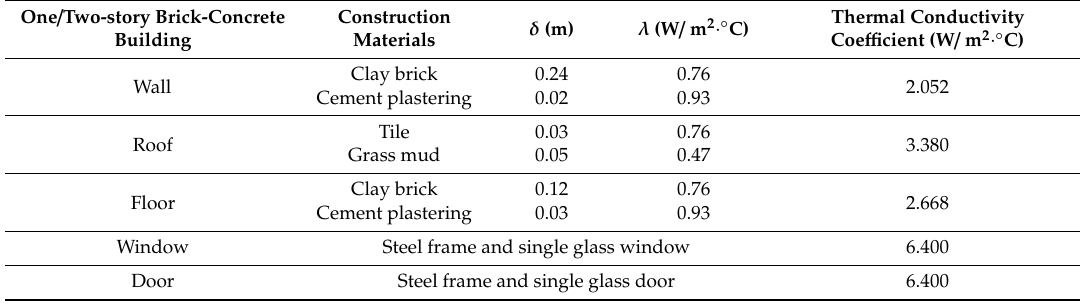
Table 12. Thermal conductivity coe ffi cient K i of one / two-story brick-concrete structure building. One / Two-story Brick-Concrete Building